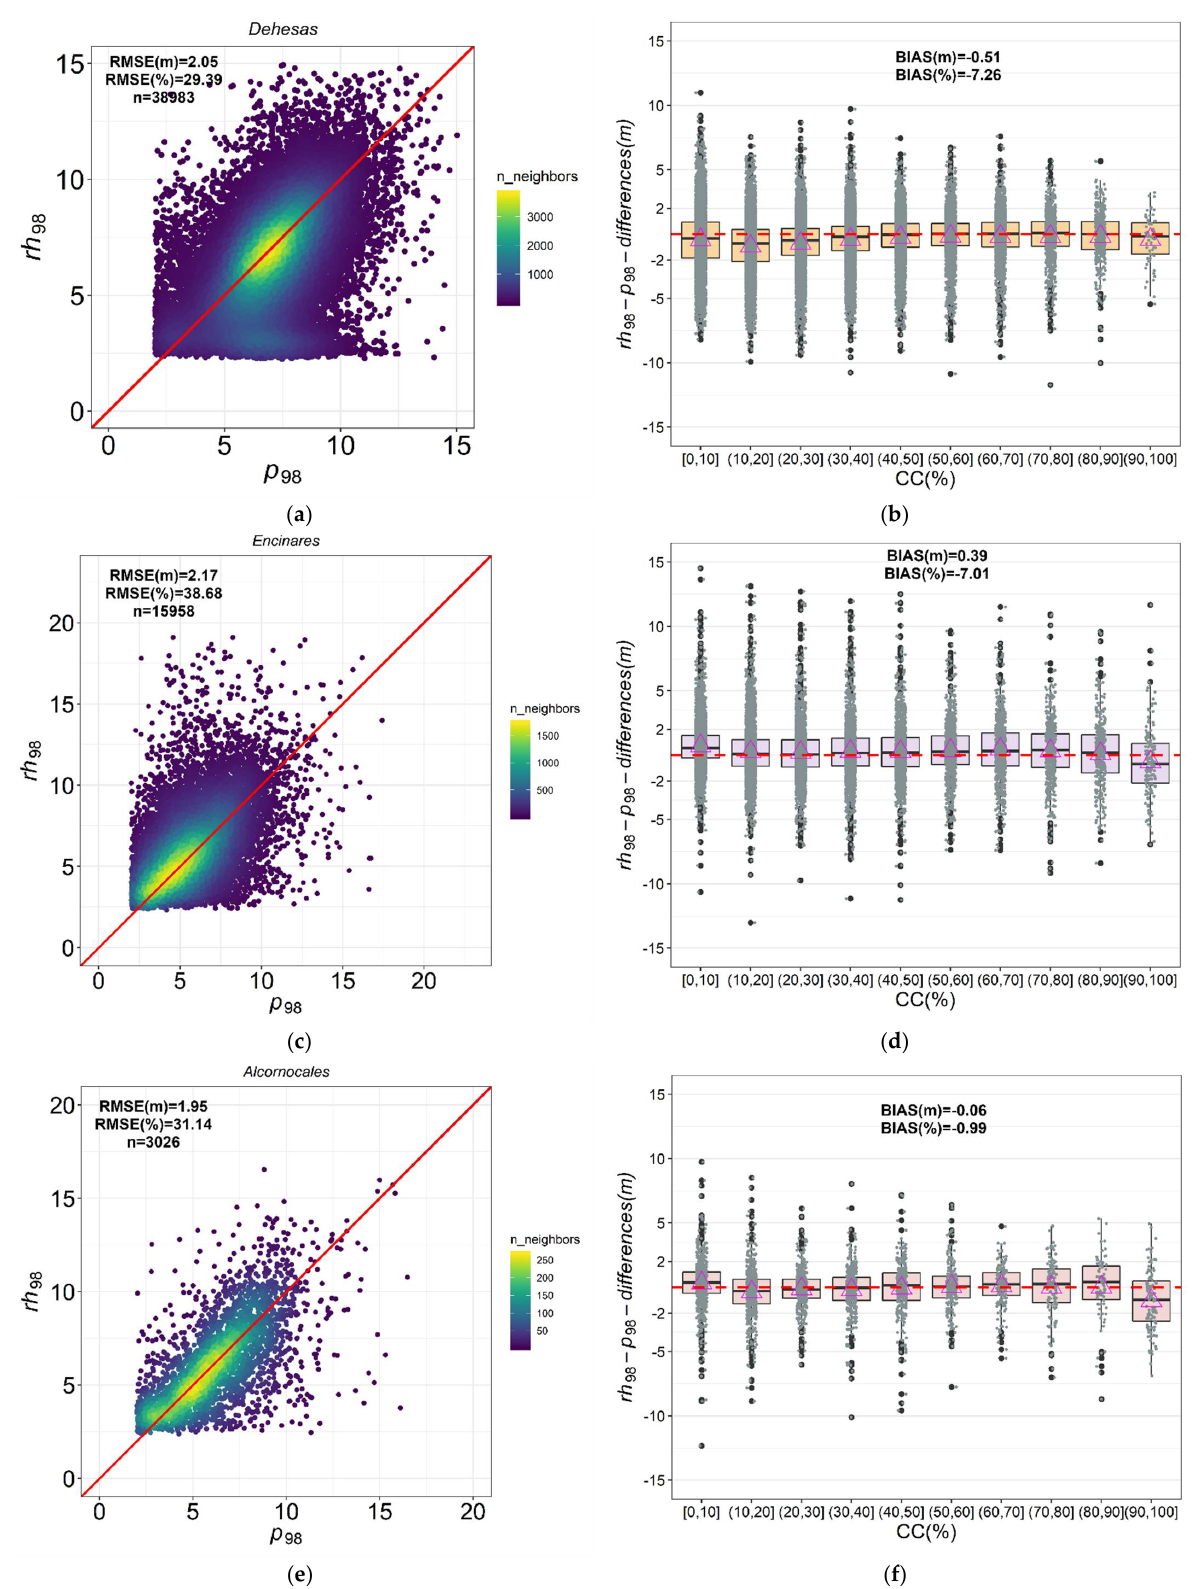
Figure 2. Scatterplots between ALS and GEDI-derived metrics for p 98 rh98 and mean difference between ALS and GEDI metrics by CC ALS (%): ( a , b ) Dehesas ; ( c , d ) Encinares , and ( e , f ) Alcornocales . The red solid line represents the 1:1 relationship in the scatterplots. Mean values of the differences between rh 98– p 98 (triangle). The dashed red line represents y = 0 in boxplots.